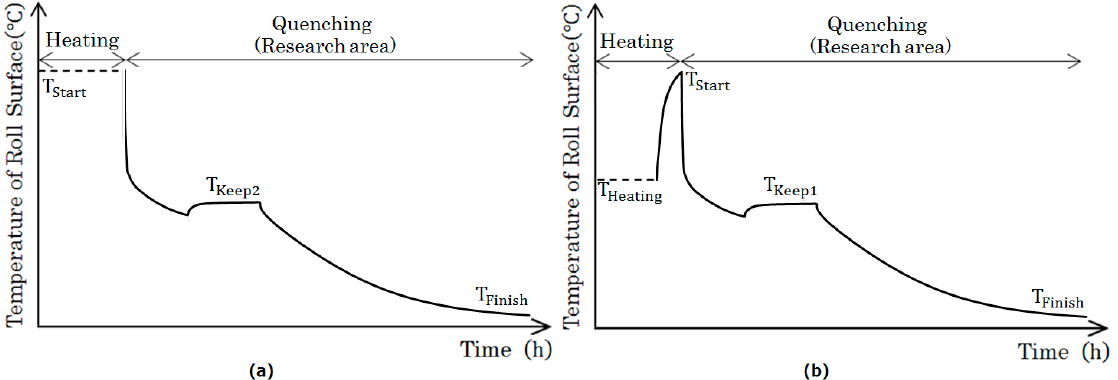
Figure 5. Schematic diagram of surface temperature for ( a ) uniform heating; ( b ) non-uniform heating.